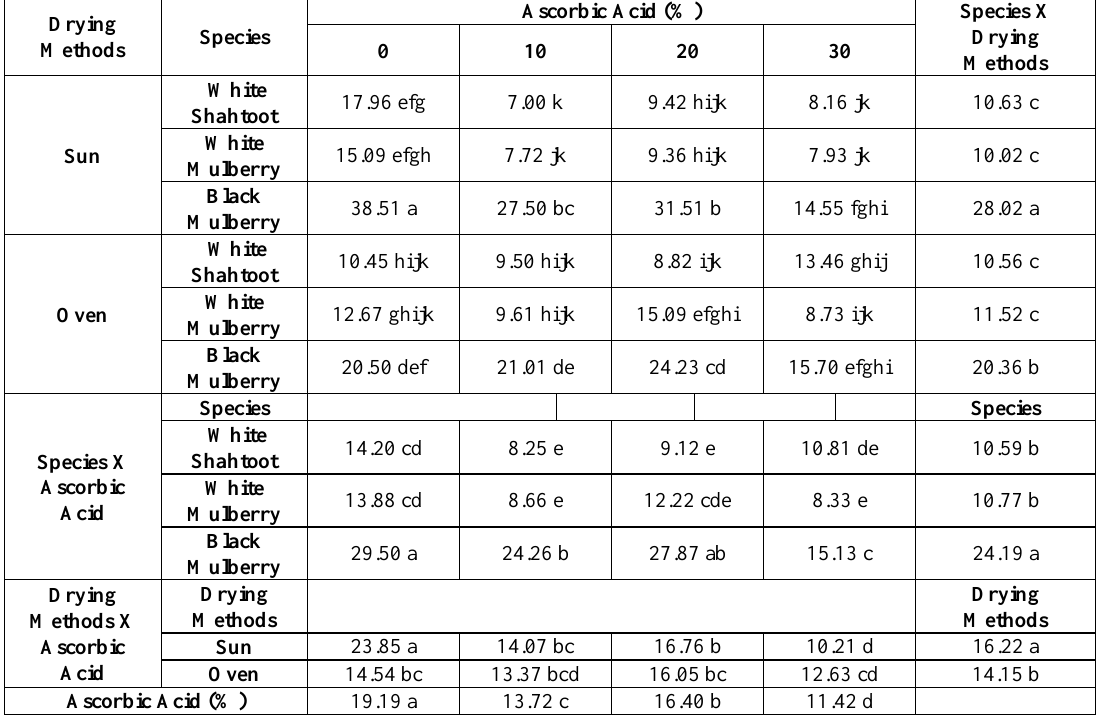
Table 4. Effect of ascorbic acid concentrations and drying methods and their interactions on total sugars content (%) of three mulberry